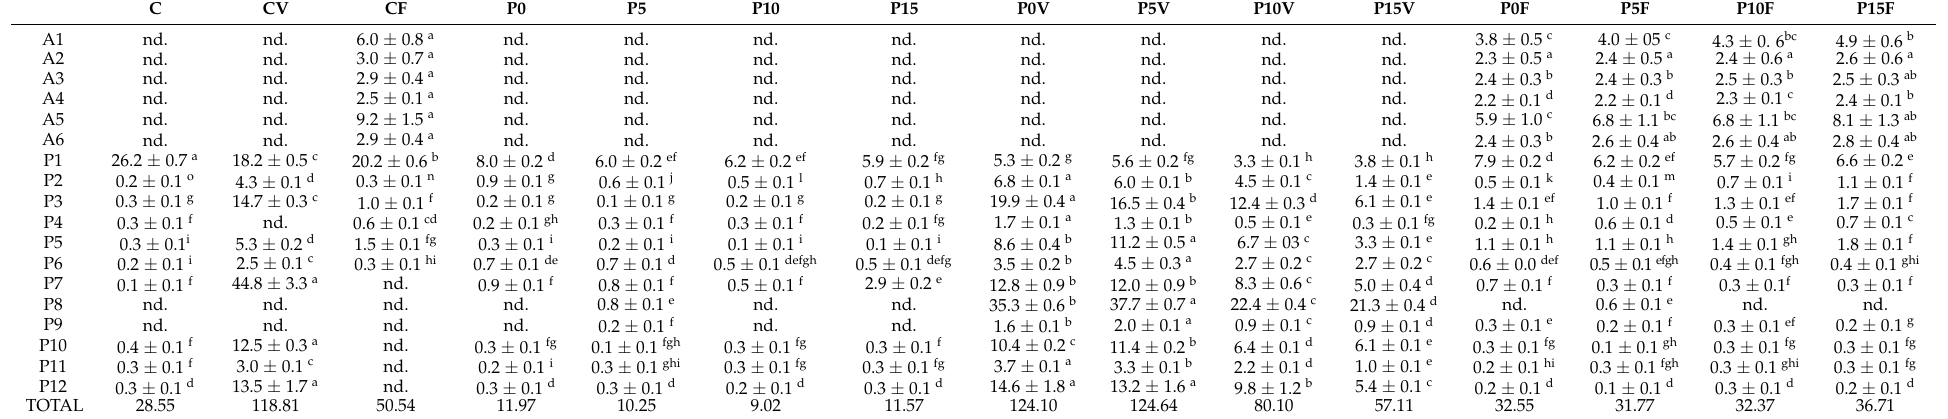
Table 3. Phenolic profile and content ( µ g/g of powder) of powdered